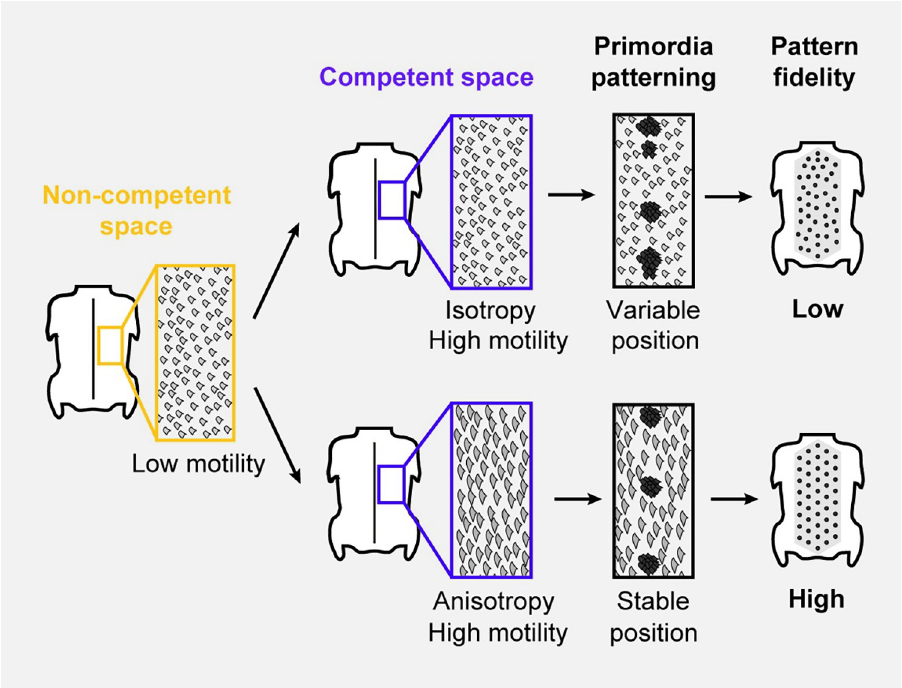
Fig 8. Natural variation in cell shape anisotropy causes differences in pattern fidelity. We propose a mechanism of pattern fidelity establishment in which non-competent patterning spaces (in yellow), characterized by low cell motility and isotropic cells, can undergo 2 scenarios, depending on species. In emus and ostriches, competence spaces (in purple) remain isotropic, and primordia position is variable, which results in low-fidelity patterns. In Japanese quails, domestic chicken, zebra finches, and penguins, competence spaces acquire early cell shape anisotropy, which constrains motility in dermal cells and stabilizes the position of nascent primordia, resulting in high-fidelity